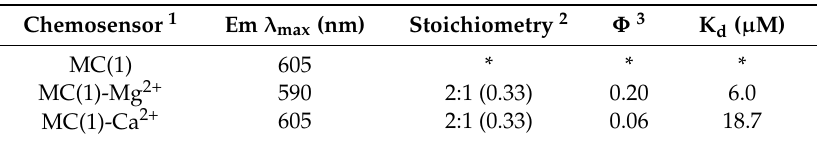
Figure 3. ( A ) Absorbance and fluorescence emission spectra of chemosensor 1 in the absence (black, 50 µ M) and presence of excess Mg 2+ (red, 100 µ M) and Ca 2+ (blue, 100 µ M), respectively. ( B ) Selectivity profile of 1 (50 µ M) in the presence of various biologically relevant metal ions (100 µ M). ( C ) Job’s plot analysis of MC( 1 )-Mg 2+ complex, where [SP] + [Mg 2+ ] = 100 µ M in acetonitrile. Excitation was at 532 nm, and all experiments were performed under ambient light conditions. Table 1. Photophysical properties of Chemosensor 1